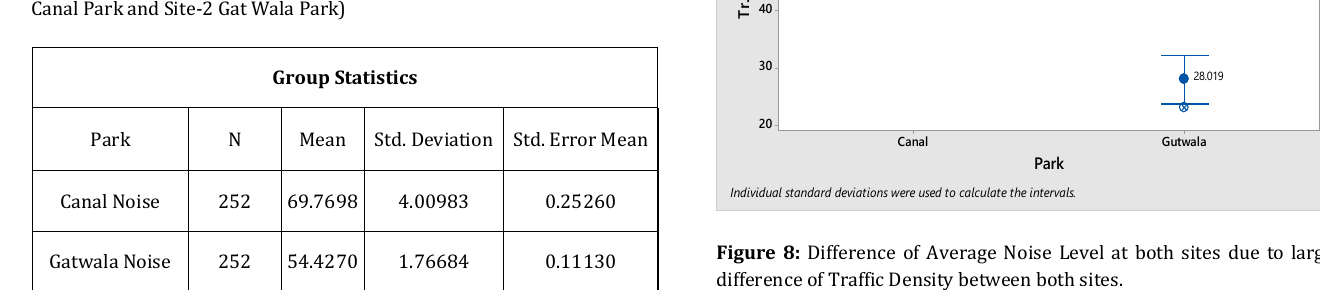
Individual standard deviations were used to calculate the Figure 8: Difference of Average Noise Level at both sites due to larger difference of Traffic Density between both sites.